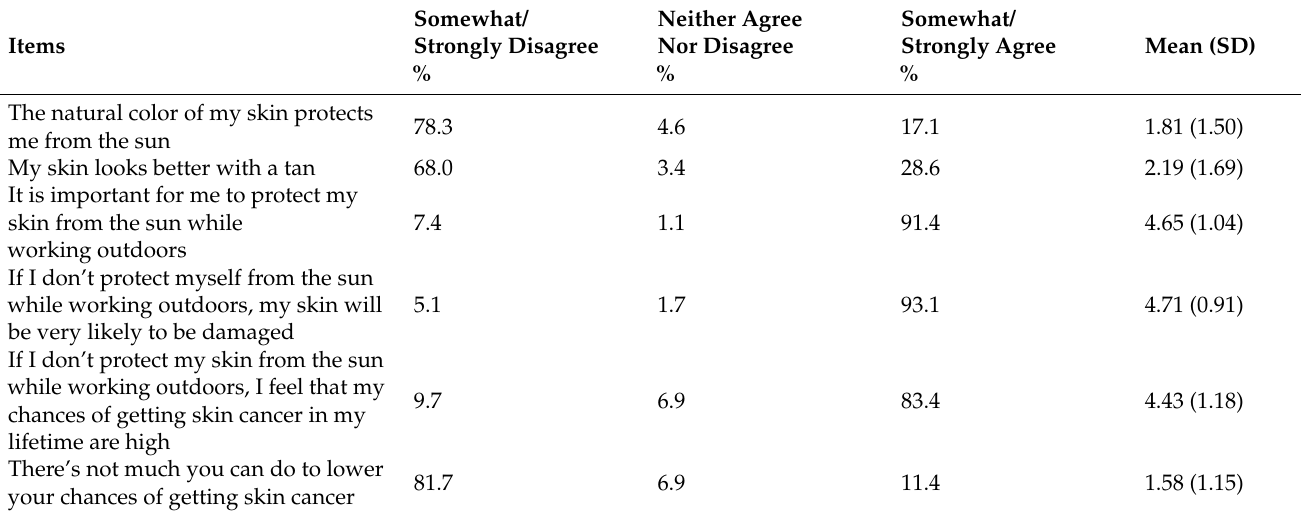
Table 3. Beliefs regarding sun protection and skin